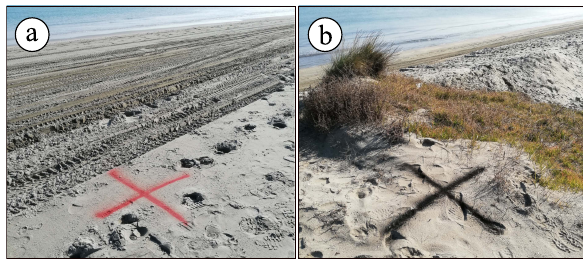
Figure 3. Ground Control Points signalisation: (a) on the shoreline, (b) on the